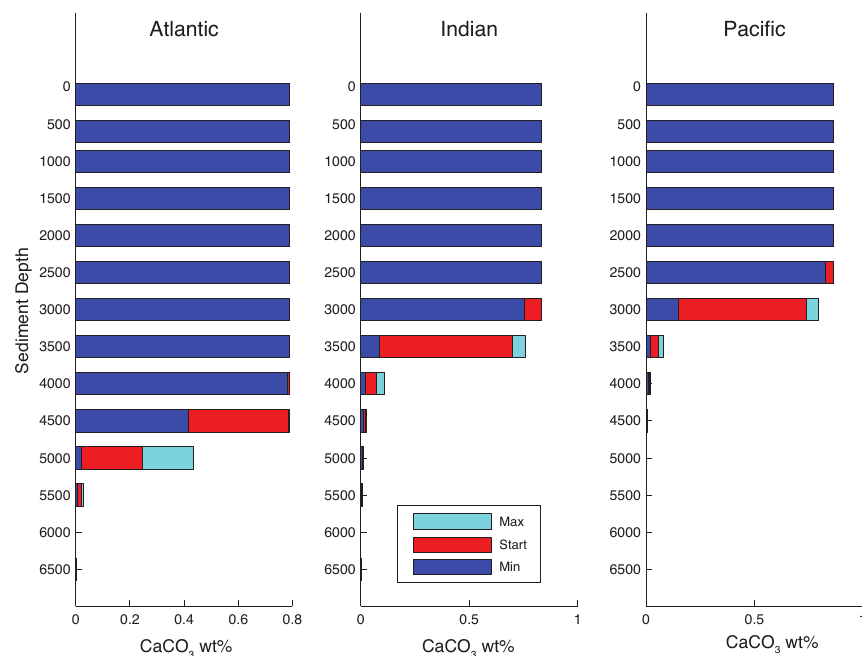
Figure 5. Extreme CaCO 3 contents in each ocean basin as a function of sediment depth for the case of E = 1000PgC and D = 5kyr.